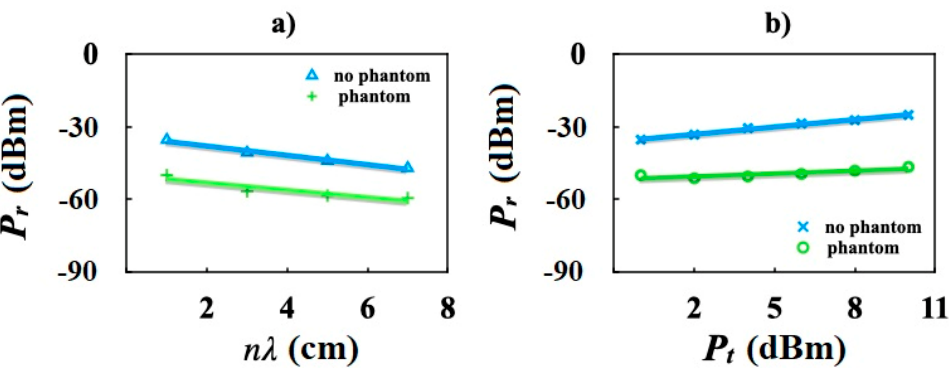
Figure 6. Comparison plots of ( a ) distance versus transmitted power with phantom ( P r (phan) = − 1.5080 ( n λ ) − 50.038, R 2 = 0.9801) and without phantom ( P r = − 1.9175 ( n λ ) − 34.057, R 2 = 0.8376); and ( b ) transmitted power versus received power with phantom ( P r (phan) = 0.3926 P t − 51.24, R 2 = 0.7356) and without phantom ( P r = 1.013 P t − 35.074, R 2 = 0.9923).